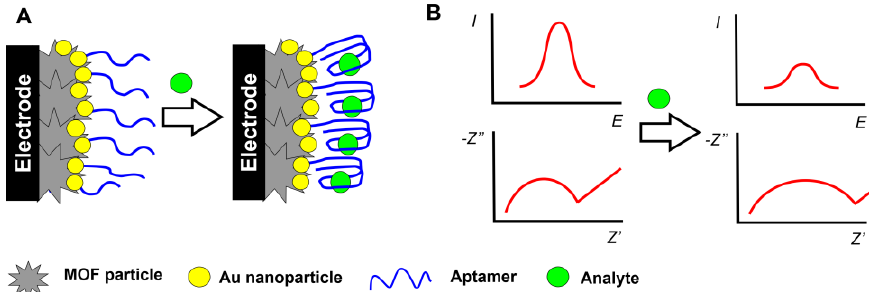
Figure 8. Monitoring aptamer–analyte interactions by the permeability of the surface layer toward small ions. ( A ) Mechanism of interaction; ( B ) changes in the signals recorded with DPV and EIS.